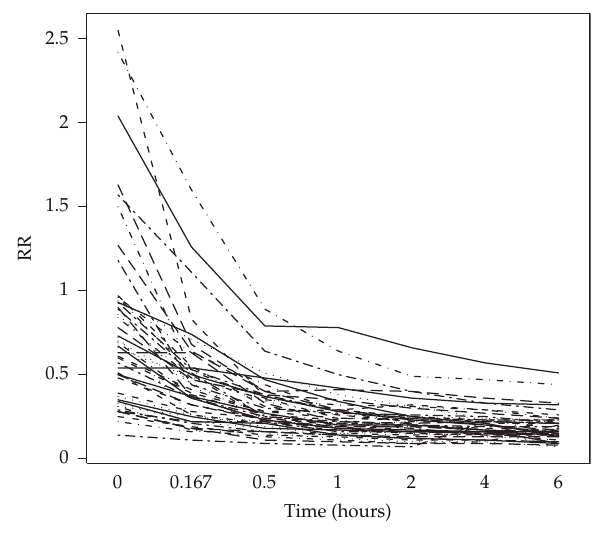
Figure 1: Individual profiles of renal resistance level for 50 sampled